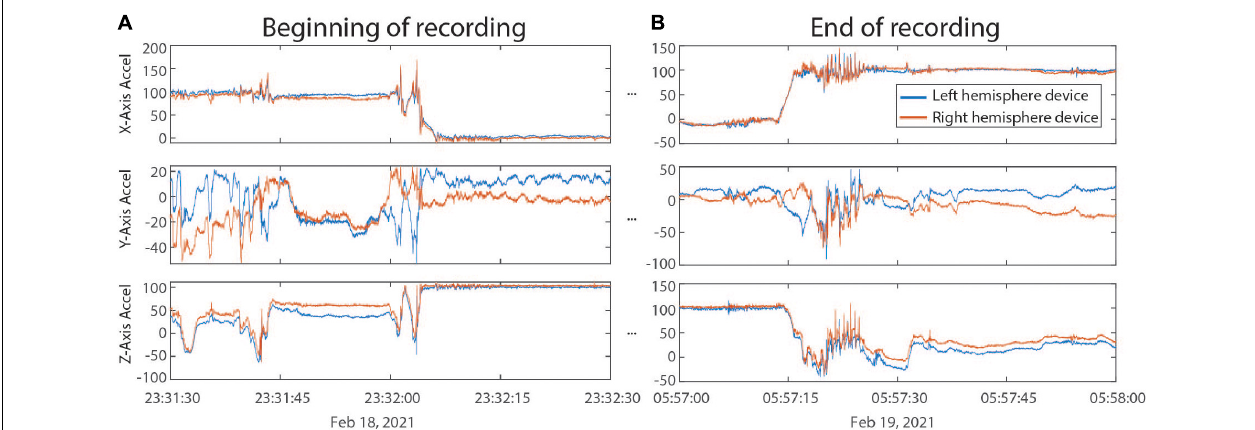
FIGURE 5 | (A) Accelerometry channels from the beginning of an overnight recording from two RC+S devices implanted in the same patient. Detected movement serves as a way of confirming the parsing algorithm, which was applied separately to data from each device, is faithfully recreating time across the recording, without any accumulated offset. (B) Accelerometry channels from the end of the same ∼ 6.5 h recording as in panel (A) . No accumulated drift is visible between the datastreams across the devices.